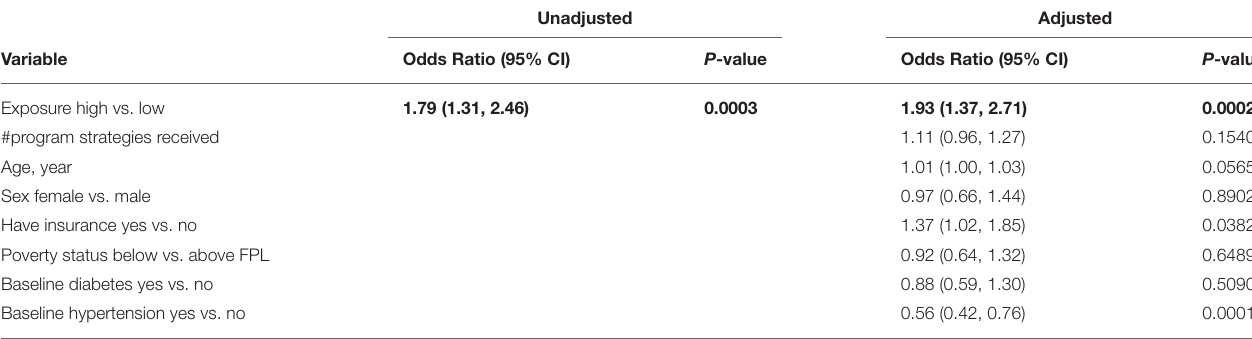
TABLE 5 | TSSC program effect on changing from Obese to Overweight/Normal (pre-obese) BMI category based on logistic regression analysis ( n = 3,075).